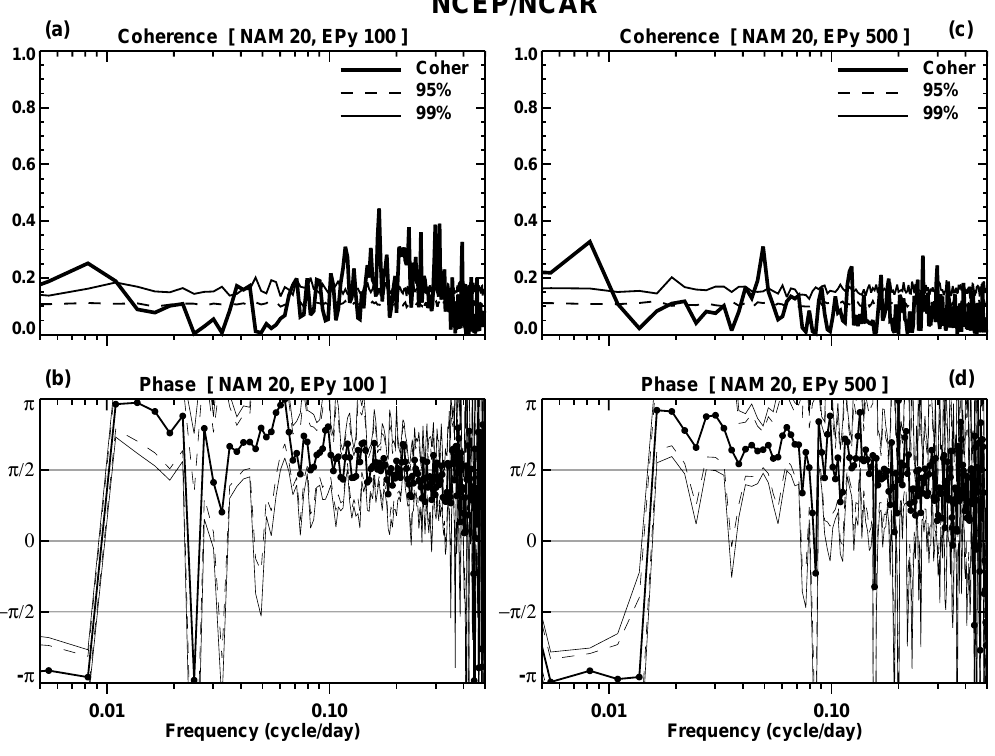
Fig. 4. As Fig. 3, but for the horizontal EP